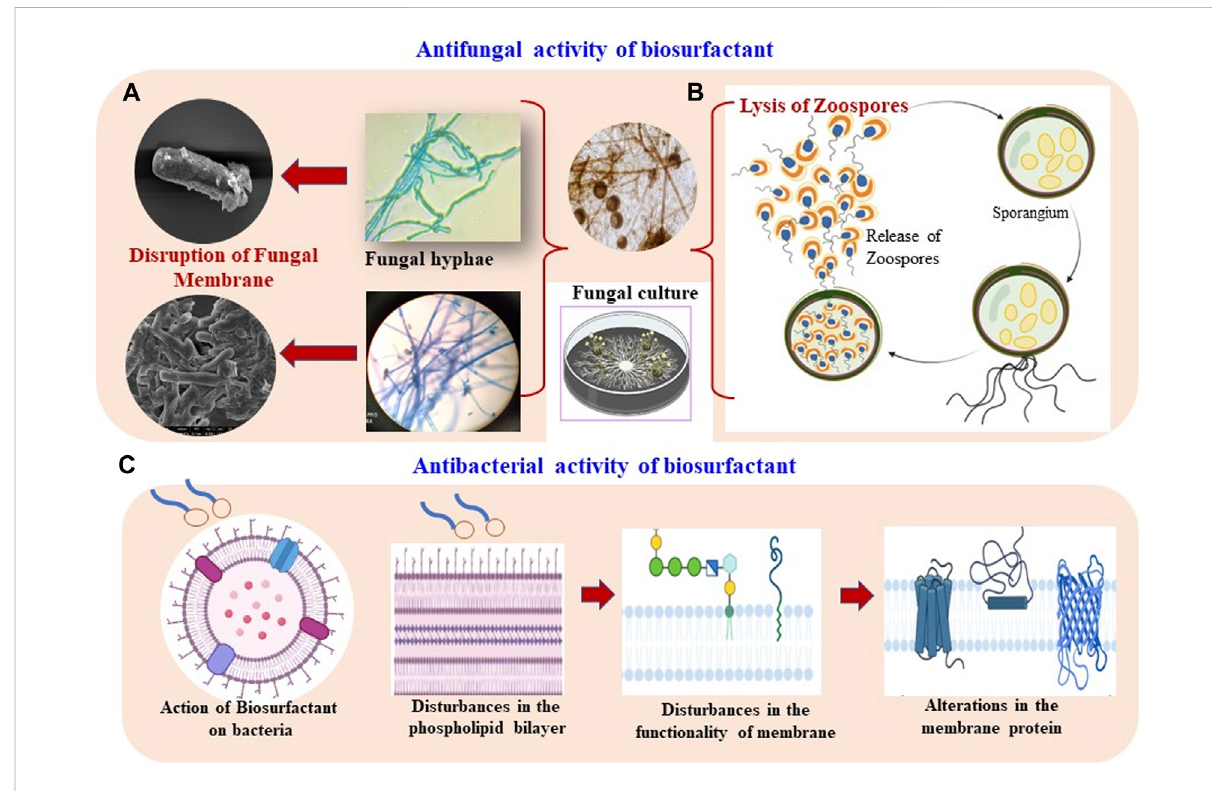
FIGURE 1 Antimicrobial potential of biosurfactants. (A) Distortion of fungal mycelia, (B) lysis of fungal zoospore, and (C) antibacterial action of biosurfactants by disturbing membrane